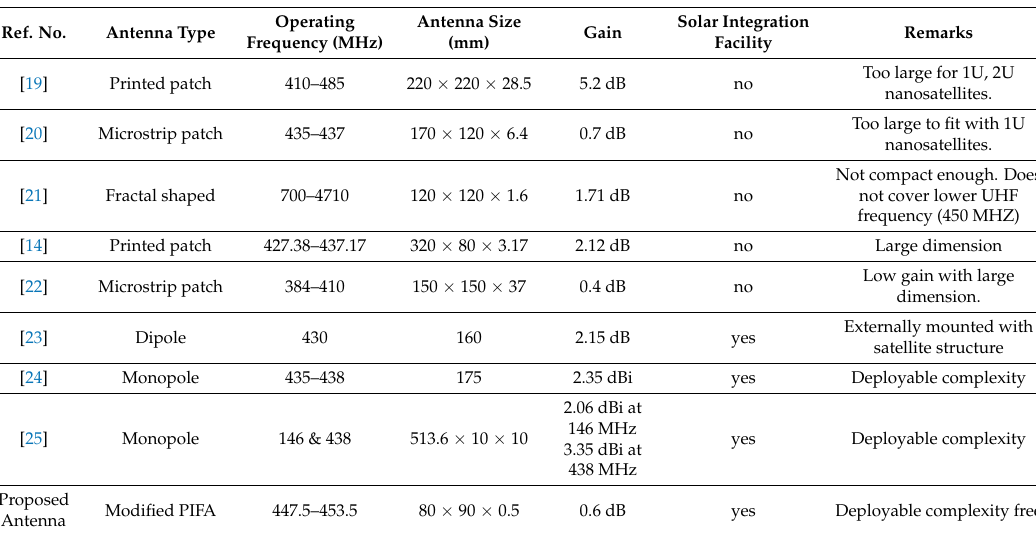
Table 3. Comparison of Characteristics of Different UHF